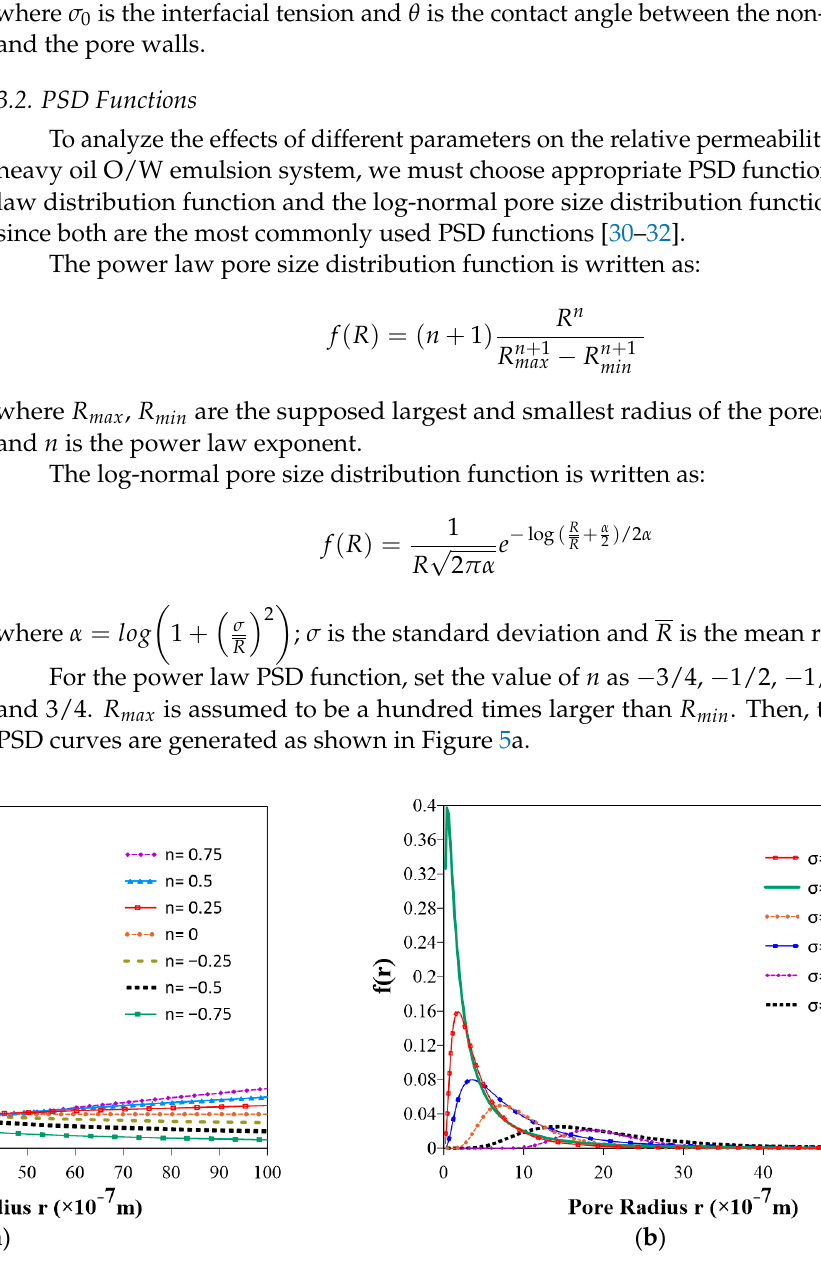
Figure 5. Different PSD function curves. ( a ) Power law PSD functions, with n value of − 3/4, − 1/2, − 1/4, 0, 1/4, 1/2 and 3/4; ( b ) log-normal PSD functions, with values of σ and R as 5, 5; 5, 10; 5, 20; 10, 5; 10, 10; 10, 20, respectively.